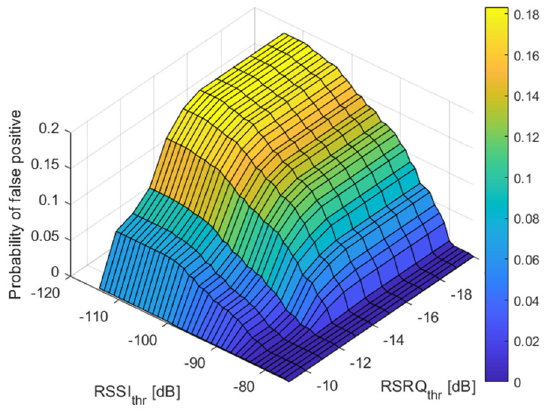
Figure 8. The probability of correct decision for different threshold values for RSSI and RSRQ while the threshold for RSRP was set to −125 dBm and the threshold for SINR was set to 0 dB.